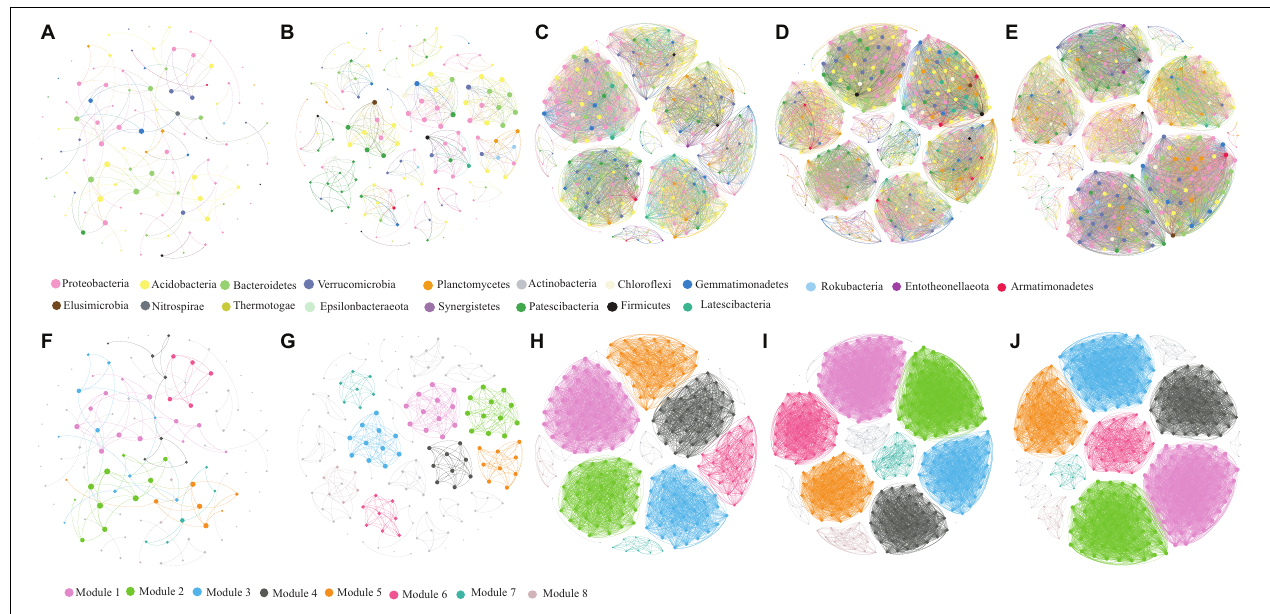
FIGURE 7 | Soil bacterial co-occurrence networks in CL (A,F) , GL (B,G) , PF (C,H) , AF (D,I) , and RD (E,J) based on correlation analysis. The nodes in network (A–E) are colored according to phylum, while the nodes in network (F–J) are colored with respect to modularity class. The size of each node is proportional to the number of